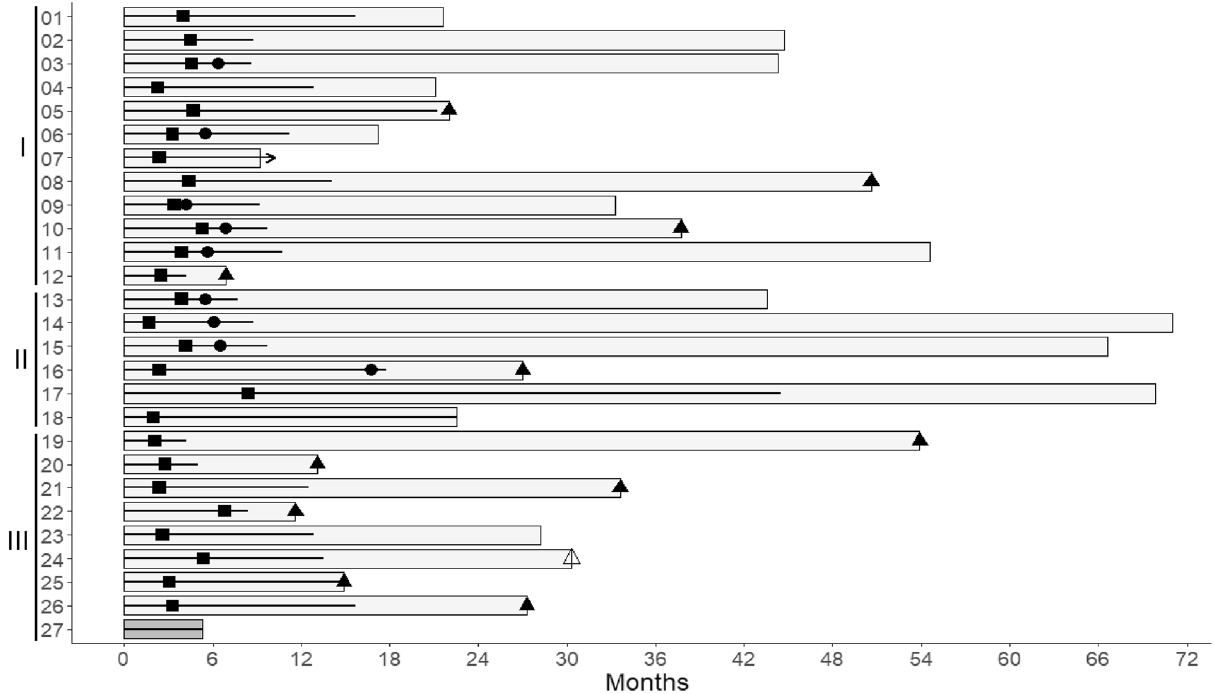
Figure 5. Chronological sequence of events in 27 patients with advanced breast carcinoma treated with regimens including FUra, folinic acid and pyridoxine in tandem. Groups of patients in ordinate comprise I, previously untreated patients whose tumors did not overexpress HER2 (1–12); II, previously untreated patients whose tumors overexpressed (3+) HER2 (13–18); and III, patients who had received prior chemotherapy whose tumors did not overexpress HER2 (19–27). Patients are numbered in the same order as in Tables 1, and 2, and in Fig. 3. Light grey bars represent progression-free survival (PFS) times in all patients except for Patient 24 where it represents event-free survival (EFS) time. Dark grey bar represents time required to final evaluation in the single patient that did not respond to therapy. Bold black lines within bars represent duration of treatment comprising FUra, folinic acid and pyridoxine in tandem, and arrow indicates ongoing treatment at the time of present evaluation. Solid squares indicate the time when a response to therapy was recorded, i.e., a reduction in sum of diameters by ≥ 30%. Solid circles represent the time when mastectomy or other type of surgery with eradication intent was performed. Solid triangles indicate the time when tumor progression was recorded in prior responders to therapy. Open triangle indicates time of event leading to withdrawal from study in a single patient with persisting response to